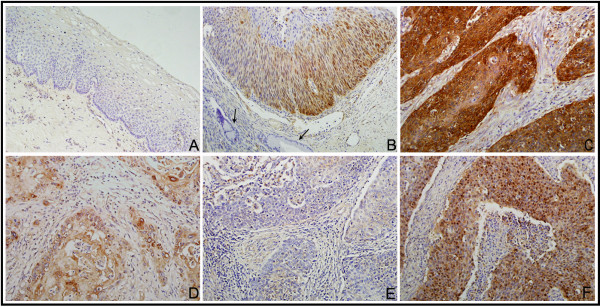
NQO1 protein expression in cervical lesions using IHC. (A) NQO1 protein was negative in normal cervical epithelia. (B) NQO1 protein staining was positive in dysplastic cells of CIN-3, but negative in adjacent normal cervical glands (arrows). (C) NQO1 protein showed diffuse and strong cytoplasmic-positive staining in late-stage cervical SCC. (D) NQO1 was weakly positive in early-stage cervical SCC. (E) NQO1 protein was negative in cervical SCC without metastasis. (F) This case of SCC showed a rare nuclear staining pattern.